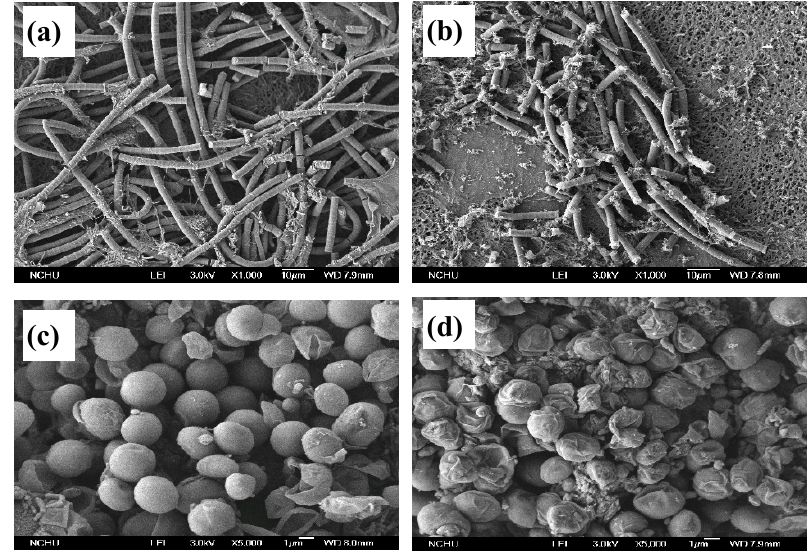
Figure 6. Electron micrographs of cyanobacteria: Oscillateria tenuisa ( a ) original (control sample); ( b ) after photocatalytic reaction; Microcystis aeruginosa ( c ) original (control sample), and ( d ) after photocatalytic